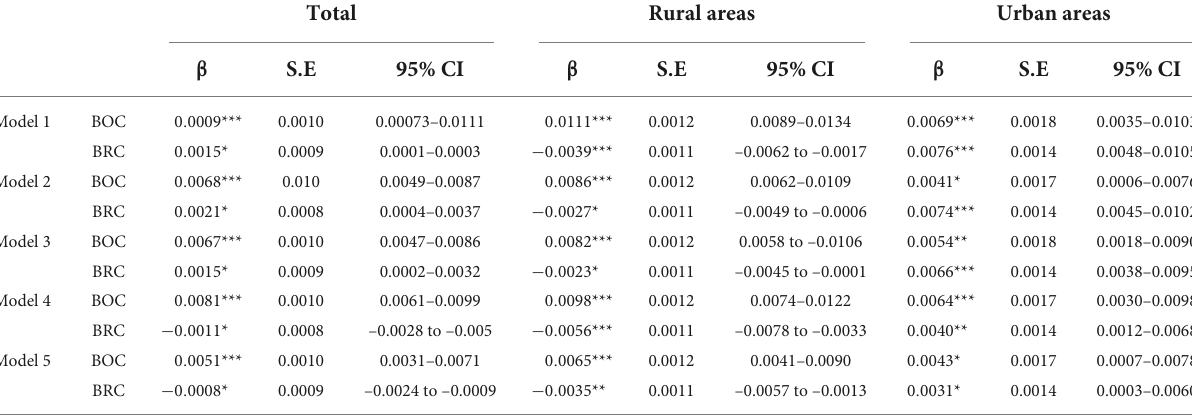
TABLE 6 The relationship between personal social capital and utility